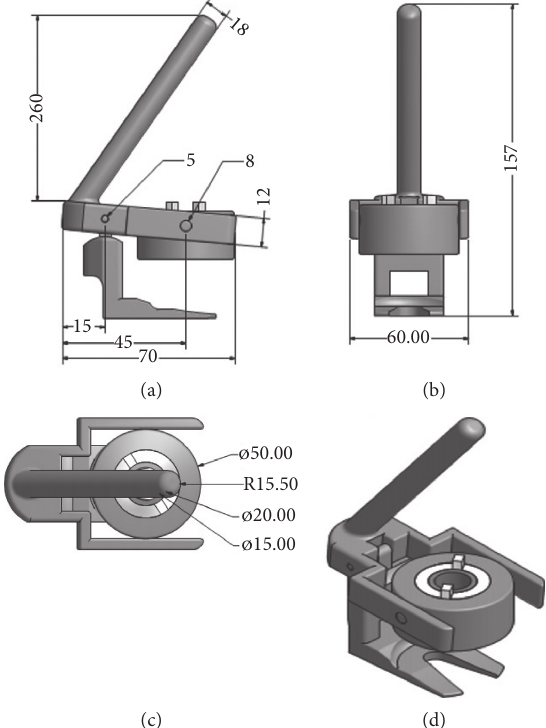
Figure 12: Projections of the poppet valve spring compressor. (a) Front view. (b) End view. (c) Plan. (d) Isometric